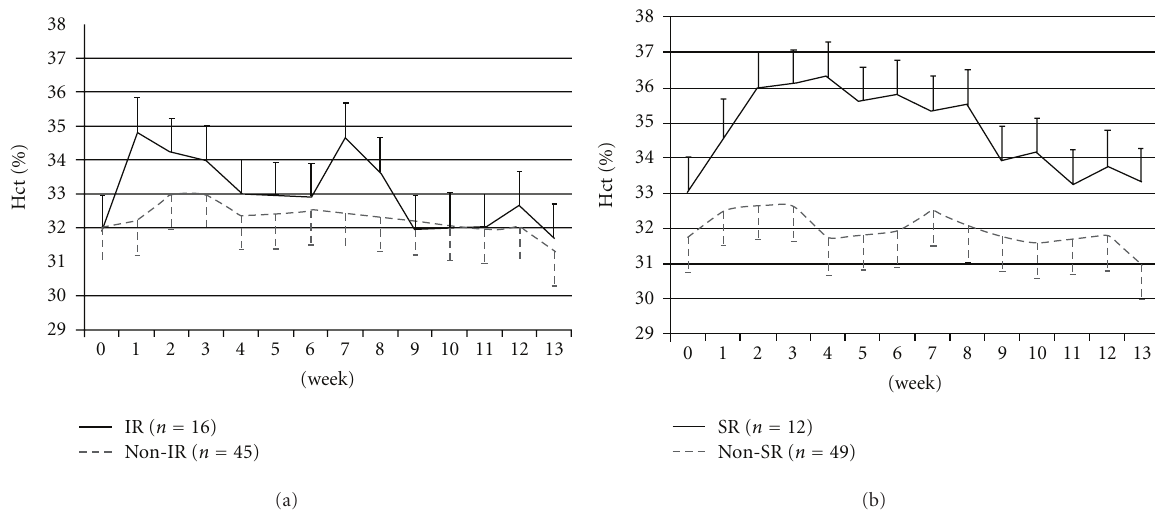
Figure 2: The Variation of hematocrit between IR and non-IR (a) and SR and non-SR (b). (a) Comparison of changes of Hematocrit after treatment of CERA between initial responders (IR) and the rest of the study group (non-IR), (b) similar comparison between sustained responders (SR) and the rest of the study group (non-SR). (The mean value and standard deviation of Hct of HD patients are displayed